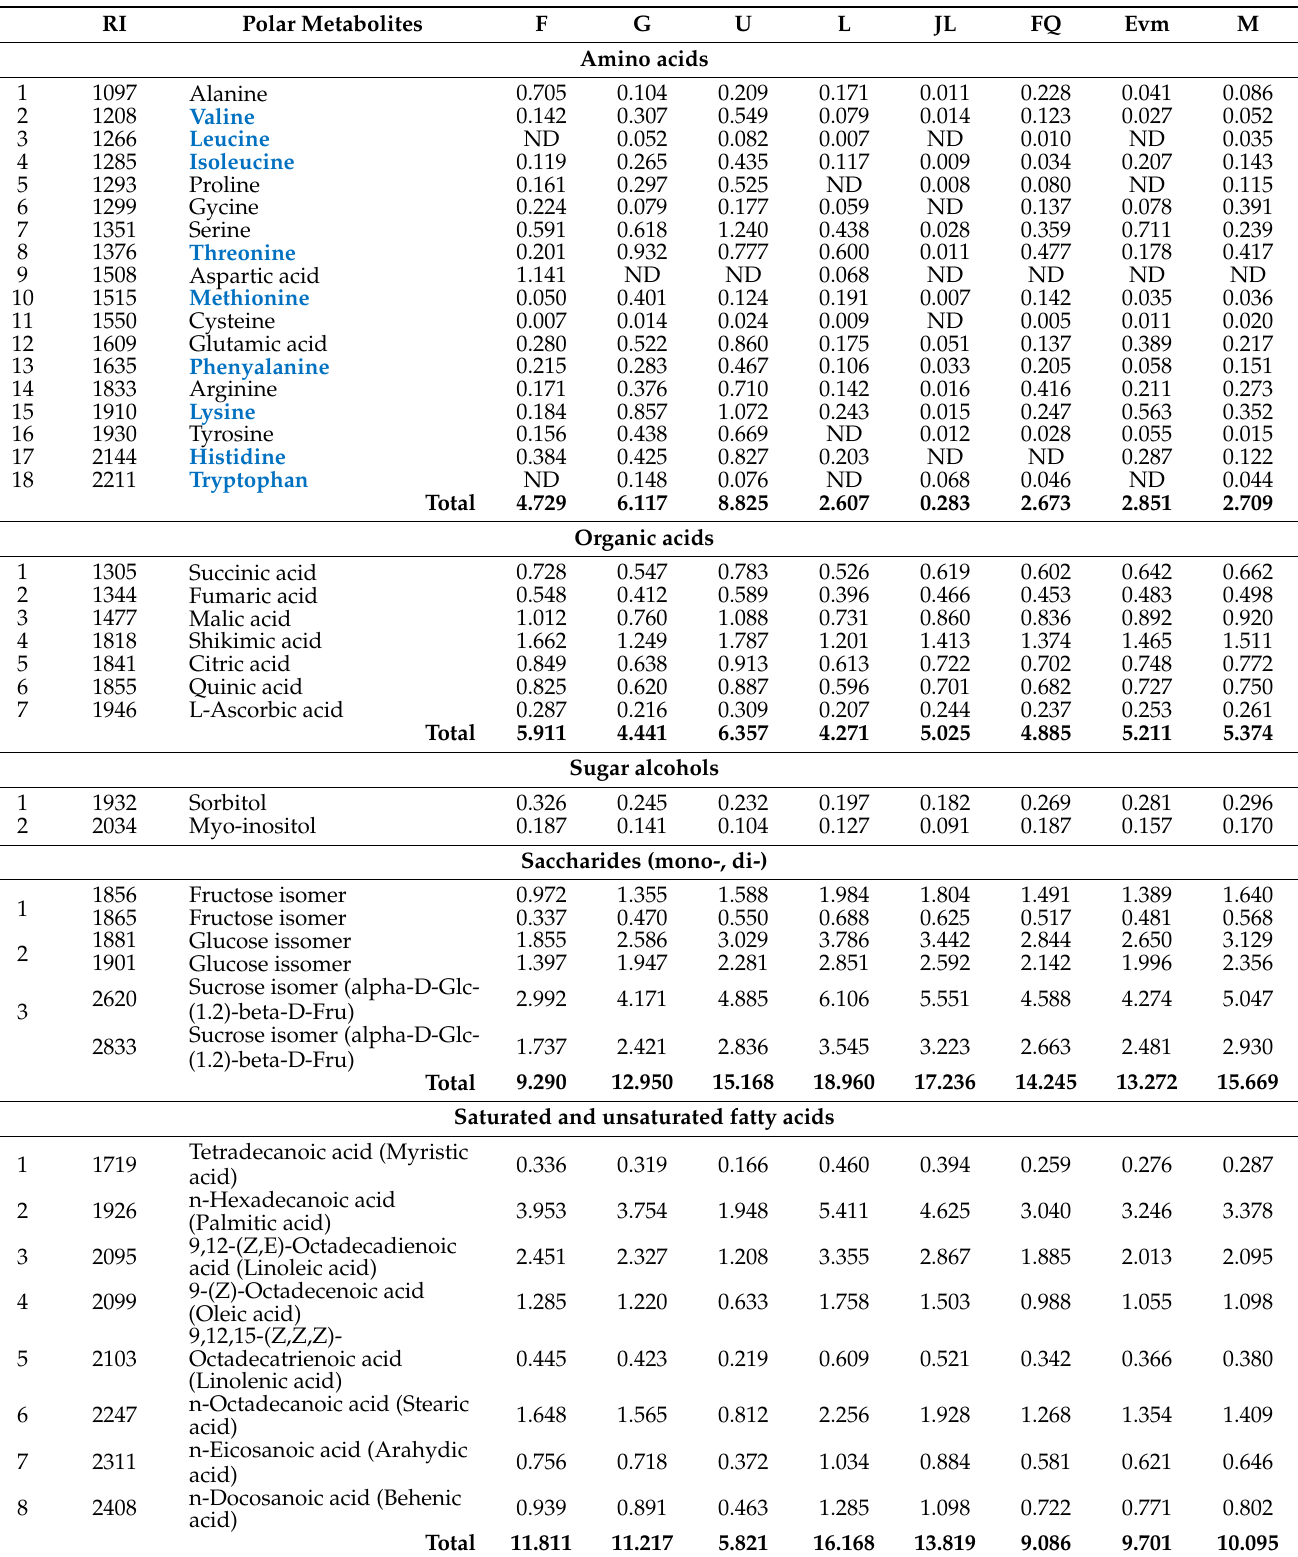
Table 1. Semi-quantification of polar metabolites (mg/g dw) of eight peach varieties’ peel